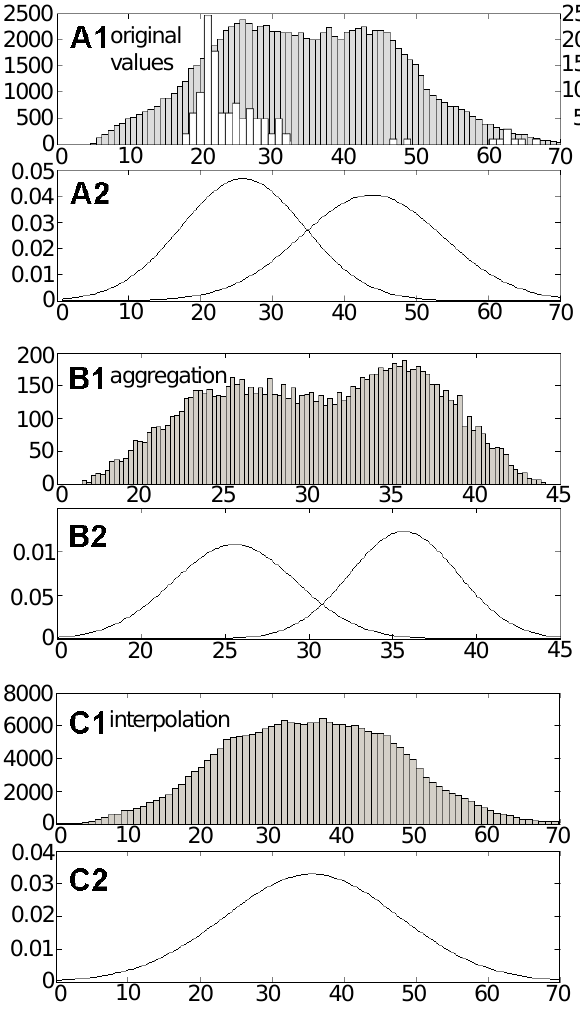
Fig. 12. Frequency distributions of cell values for the fine sand content, given in % on the x-axis for the simulated eastern part of the Chicken Creek catchment. (A) Original frequency distri- butions from the structure generator are bimodal. The white bars in A1 show the histogram for measurement data from raster grid sampling. (B) During aggregation of the original values in the raster grid cells of the volume body in GOCAD, frequency distri- butions are modified. (C) After linear interpolation (DSI) between grid cells, the bimodal distribution has